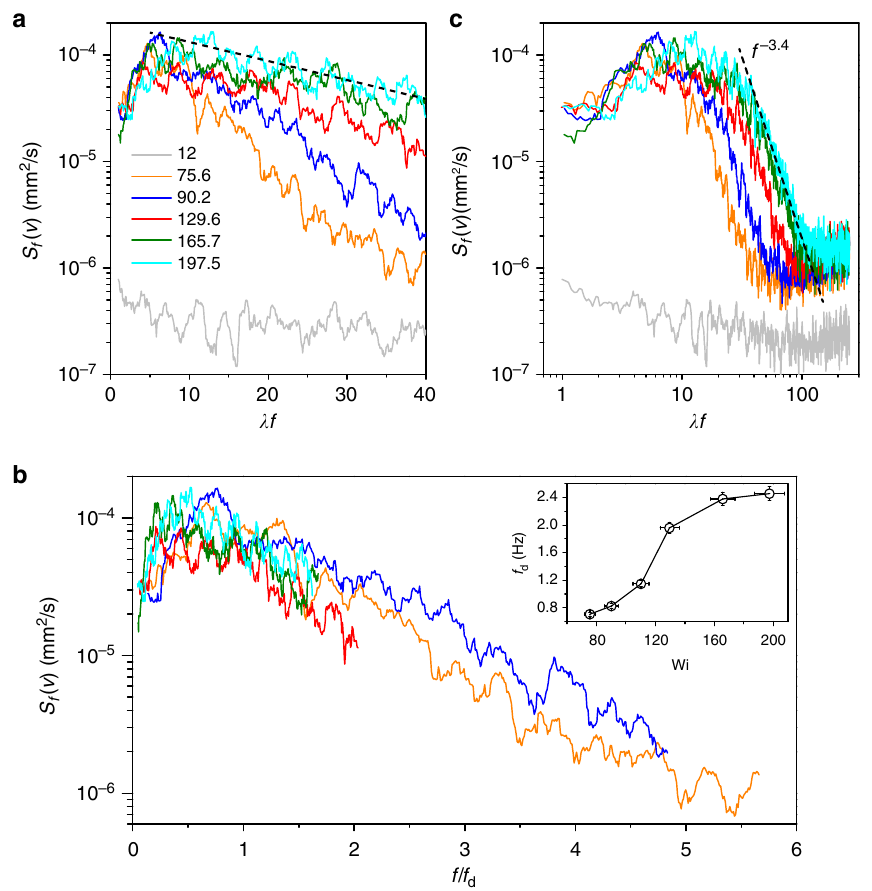
Fig. 3 Cross-stream velocity power spectra versus normalized frequency in elastic turbulence. a Cross-stream velocity power spectra S f ( v ) in log-lin coordinates to emphasize an exponential decay of the oscillation peak values at low frequencies λ f ≤ 40. An exponential decay is shown by the dashed line, e.g., for the case of Wi = 197.5. b S f ( v ) for different Wi collapse on to each other upon normalization of f with f d . Inset: variation of f d with Wi. The error bars on f d are estimated based on standard deviation (s.d.) of exponential fi t of S f ( v ) versus f , and for Wi they are calculated based on the s.d. from the mean value of fl uid discharge rate Q (see Methods section). c S f ( v ) in log-log coordinates, for different Wi, to demonstrate the power-law decay at high frequencies ~10 < λ f ≤ 100. The spectra are obtained at ( x / R , y / R ) = (5.2, 0.56), which is close to the downstream obstacle and to the center of the upper large vortex. The dashed line in c is a fi t to the data at high frequencies with the power-law exponent α f ≃ − 3.4 ± 0.1, typical to the ET regime. S f ( v ) of steady fl ow is shown by gray lines in a ,